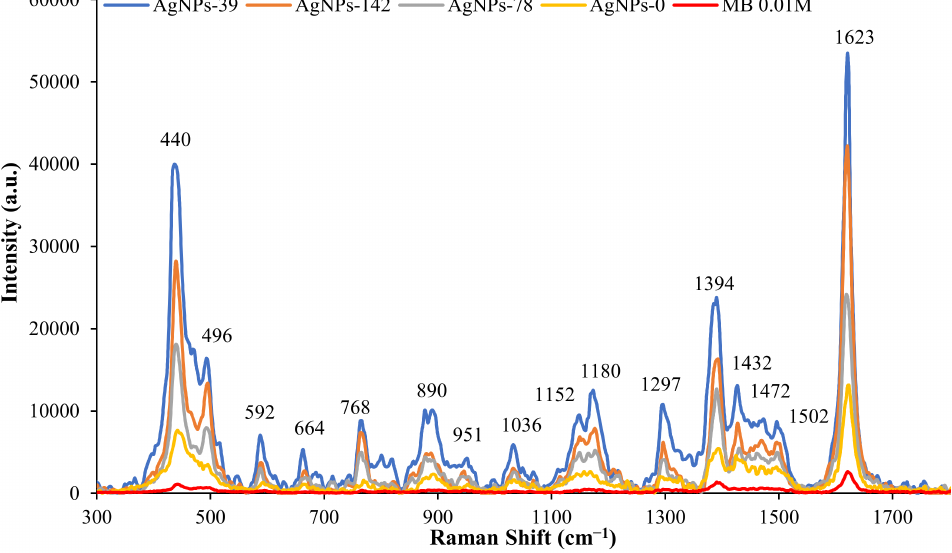
Figure 3. SERS spectra of MB 1 µ M with AgNPs-0 (yellow), AgNPs-78 (grey), AgNPs-142 (orange), AgNPs-39 (blue) and the normal Raman spectrum of MB 0.01 M (red). Table 2. Raman shifts and band assignments for Methylene